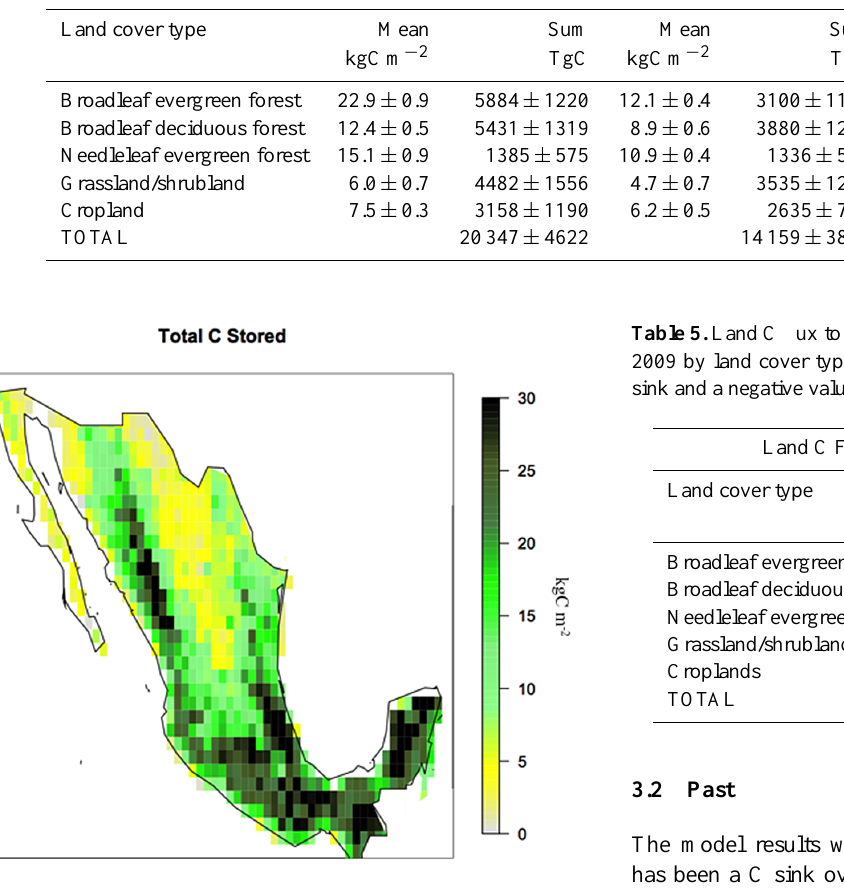
Table 4. Mean (kgCm − 2 ) and total (TgC) carbon stored in the vegetation and soil in each land cover type for the period 2000–2005. Total stored C